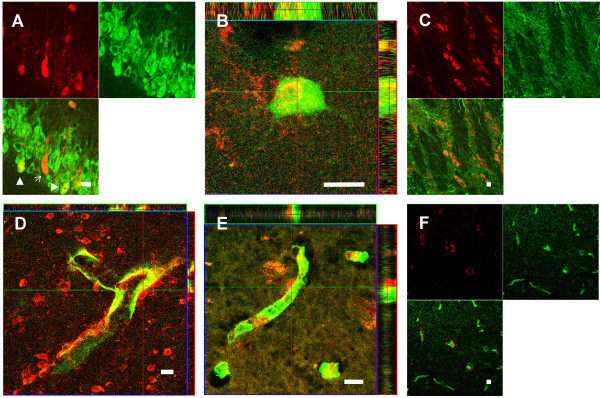
Micrographs showing multiple-labelled tissue of the rat, macaque and human brain (A-F). (A) Split image displaying labelling of YB-1 (red) and NeuN (green) and double-labelling (merged figure) in the hippocampal cornu ammonis (CA-1) formation of a rat brain. Representative examples of cells showing nuclear YB-1 expression are indicated by bold white arrowheads while a narrow arrow indicates a cell with cytoplasmatic expression of YB-1. (B) High magnification image of a neuron indicated by NeuN expression (green) with a clear nuclear staining of YB-1 (red) in the parietal cortex of a macaque. (C) Split image showing the expression of YB-1 (red) and the glial marker GFAP (green) in the hilus of the dentate gyrus of a rat. Note the absence of any glial expression of YB-1 in the merged figure. (D, E) Confocal image showing the expression of YB-1 (red) and the expression of the endothelial cell marker Glut-1 (green) in the macaque and human brain. (D) Image displaying the expression of YB-1 (red) and Glut-1 (green) in the parahippocampal cortex of a macaque monkey. Note the lack of co-localization of YB-1 and Glut-1 expression, as clearly indicated by confocal z-series. (E) Image displaying the expression of YB-1 (red) and Glut-1 (green) in the human parahippocampal cortex. In accordance with data obtained from rats (data not shown) and macaques, YB-1 proved not to be expressed by Glut-1 positive endothelial cells. (F) Split image of a confocal micrograph giving an example of YB-1 expression (red) and expression of the endothelial multidrug transporter Pgp (green) in the parietal cortex of a rat. In accordance with the data from the YB-1/Glut-1 double-labelling in the different species, YB-1 does not co-localize with endothelial Pgp expression (merged figure). Scale bar = 10 μm.